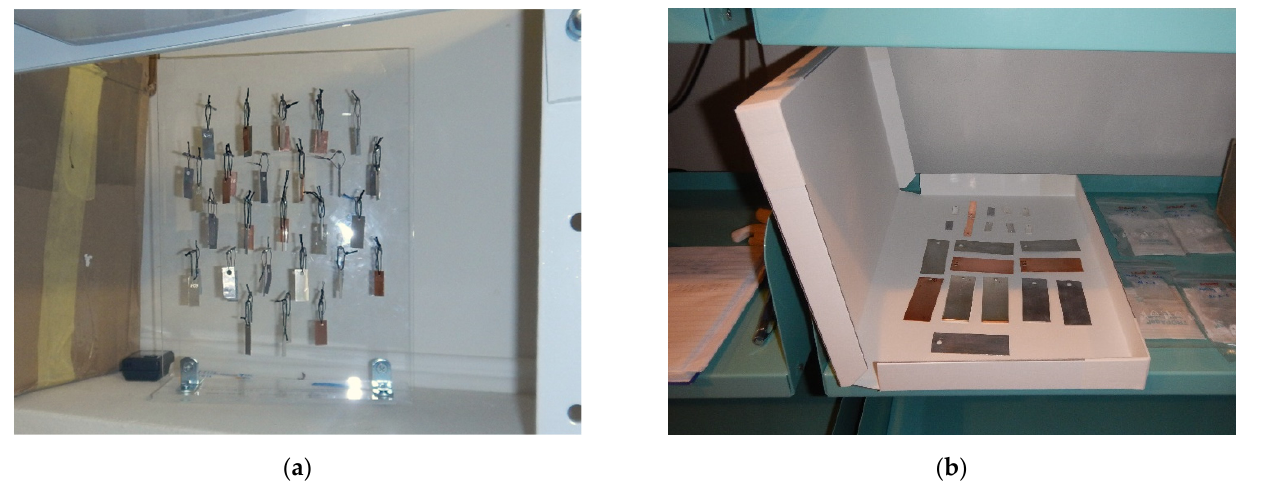
Figure 1 . Corrosion coupons: ( a ) fixed to stand at location 13; ( b ) placed in modern archive box at location 10 .